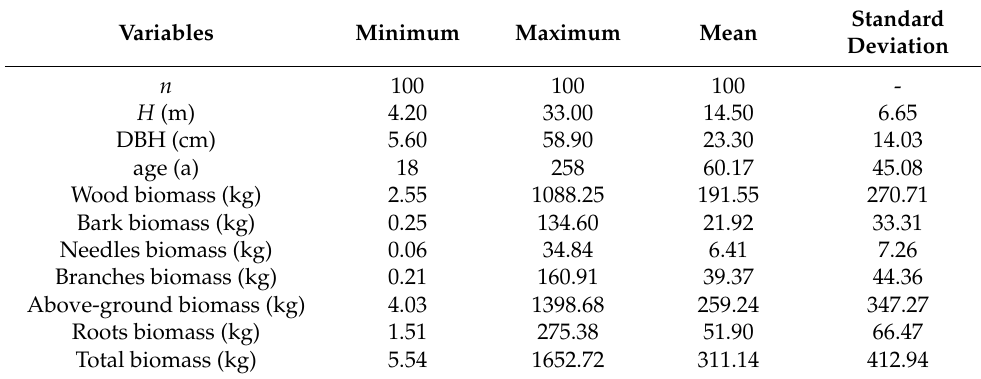
Table 2. The primary characters of the sampling trees ( n = 100). n is the number of trees, H is the tree height, DBH is the diameter at breast height, and age is the tree age. Variables